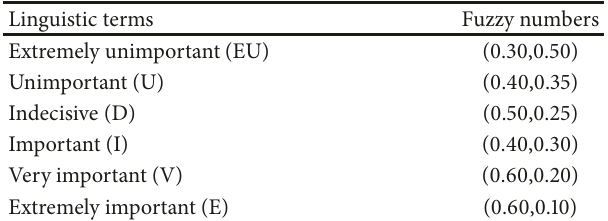
Table 6: Linguistic terms for the weights